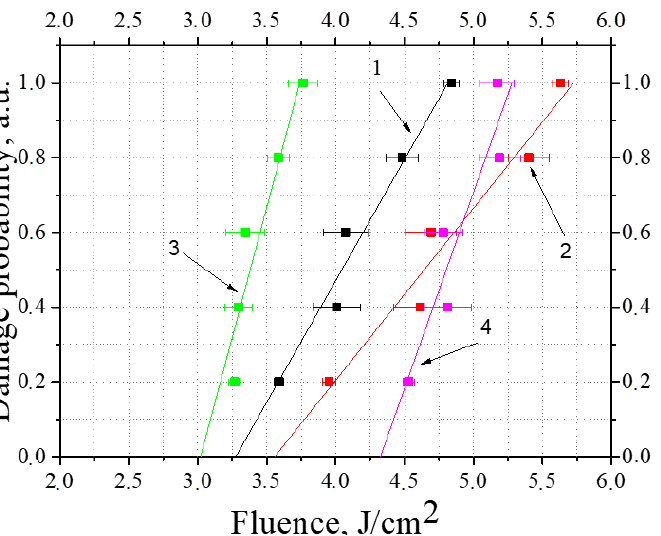
Figure 2. Damage probability vs the laser beam fluence for the ZnSe samples annealed in different atmospheres: an initial ZnSe sample without annealing, ZnSe_org (1); the ZnSe sample annealed in selenium, ZnSe_Se (2); the ZnSe sample annealed in zinc, ZnSe_Zn (3); the ZnSe sample annealed in argon, ZnSe_Ar (4). The pulse repetition rate (PRR) of the Ho 3+ :YAG laser was 12 kHz, the exposure duration was 1 s.